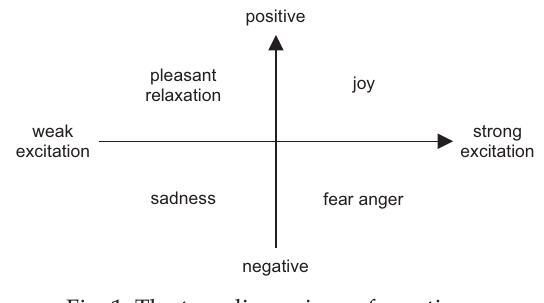
Fig. 1. The two dimensions of emotions. Source: Myers